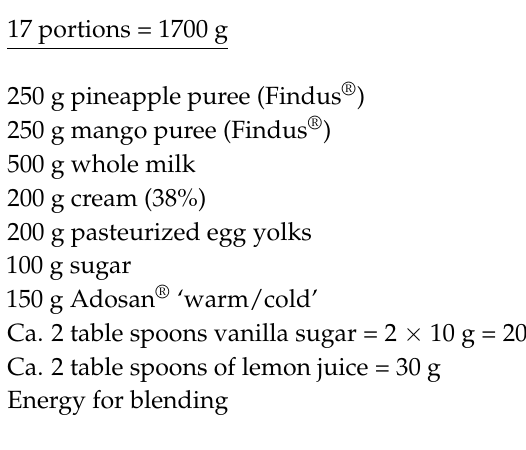
Ca. 2 table spoons vanilla sugar = 2 × 10 g = 20 g Ca. 2 table spoons of lemon juice = 30 g Energy for blending Procedure: Blend all ingredients for at least 90